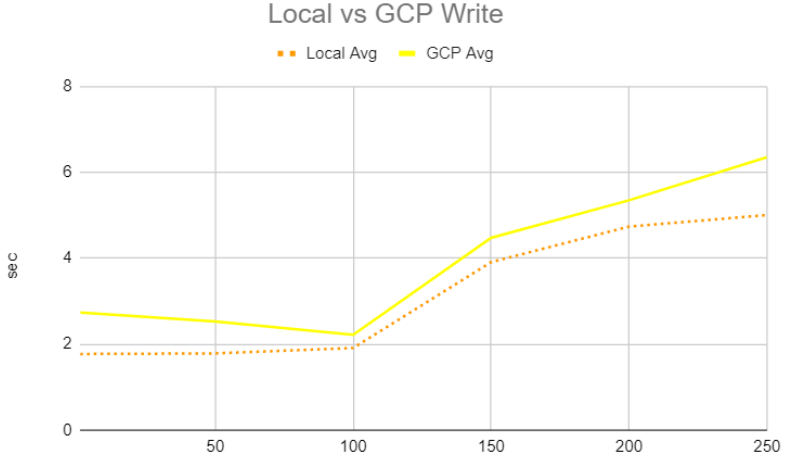
Figure 8. Average write latency comparison of a 4-node GCP and a local Docker Indy ledger.